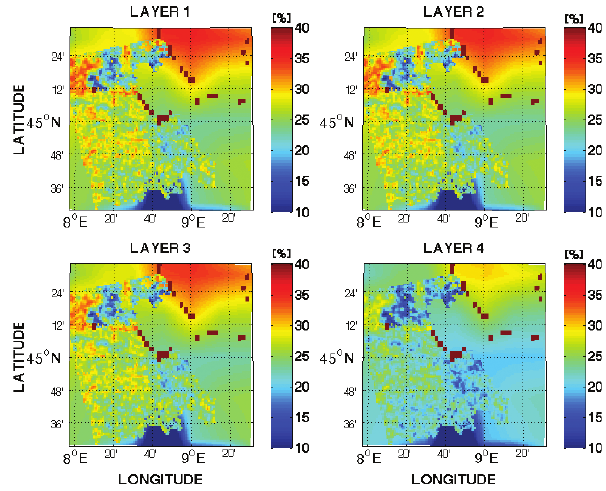
Fig. 6. Volumetric SMC (%) resulting from the merging procedure of the ASAR retrieval and the ECMWF analysis at the four MM5 soil layers, valid on 25 April,